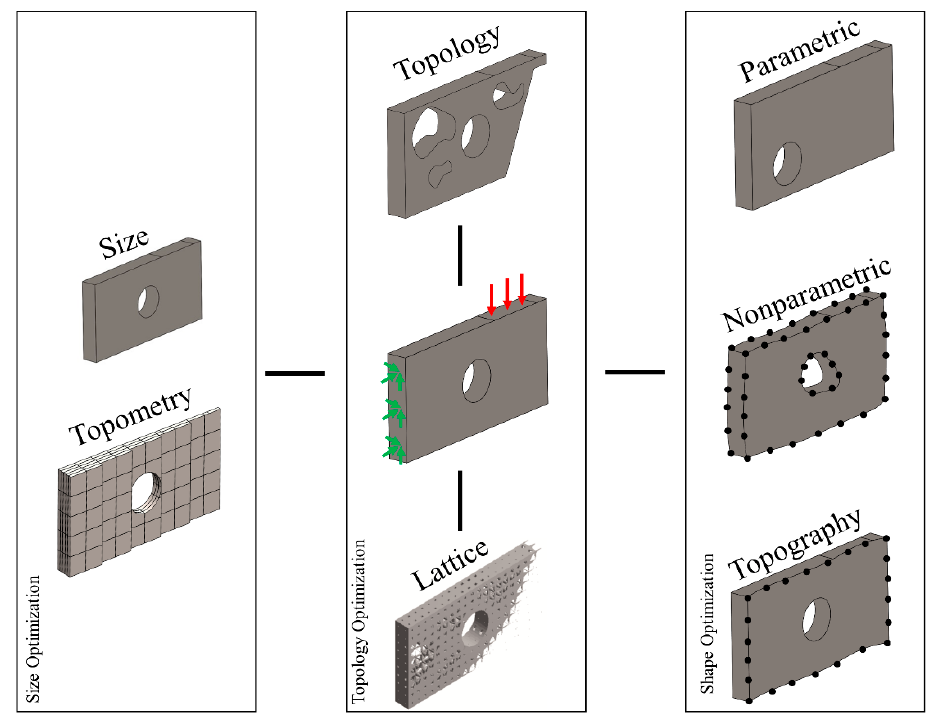
Figure 1. The different Structural Optimization (SO) types of a Hollow Plate. Figure 1. The di ff erent Structural Optimization (SO) types of a Hollow